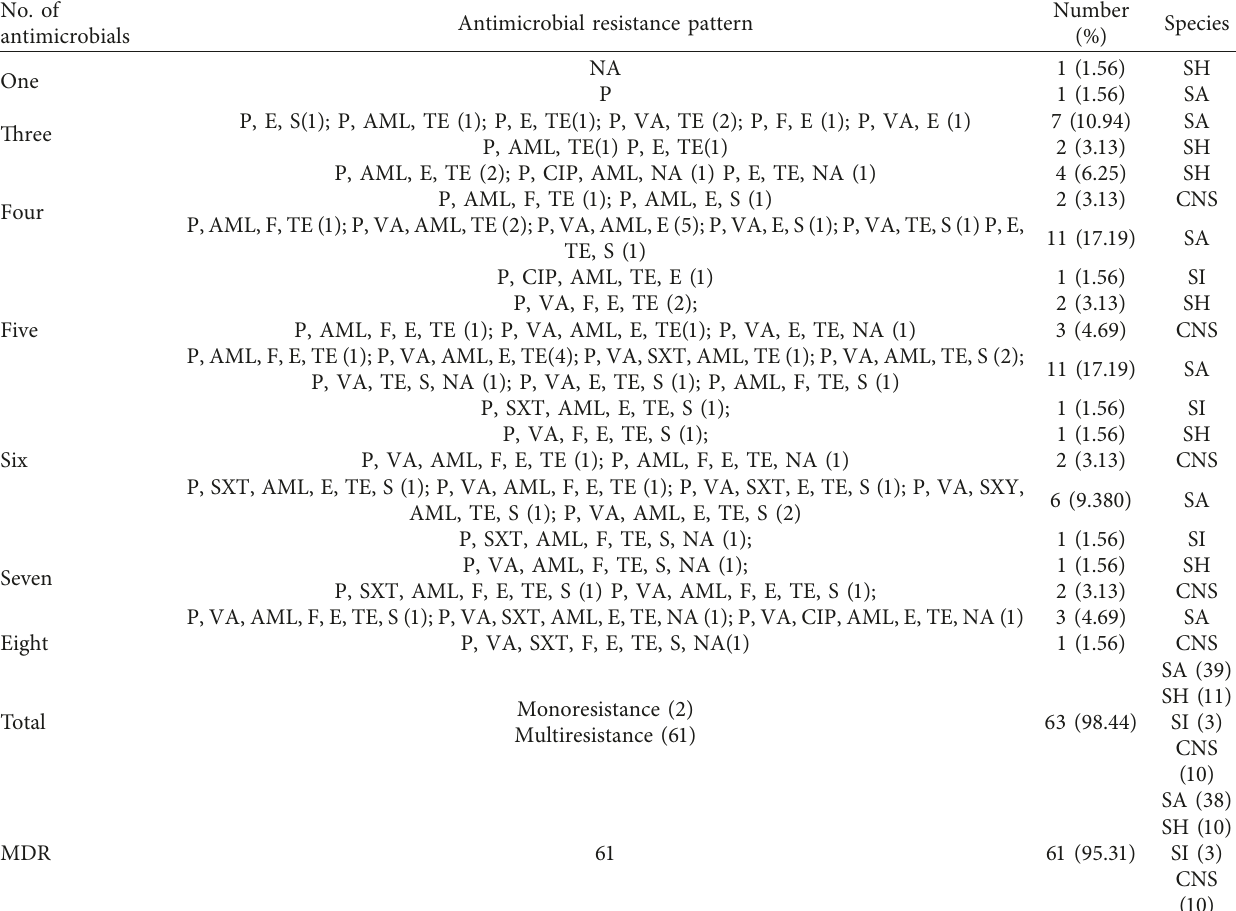
Table 5: Number and percentages of antimicrobial resistance patterns of Staphylococcus species. No. of Antimicrobial resistance antimicrobials